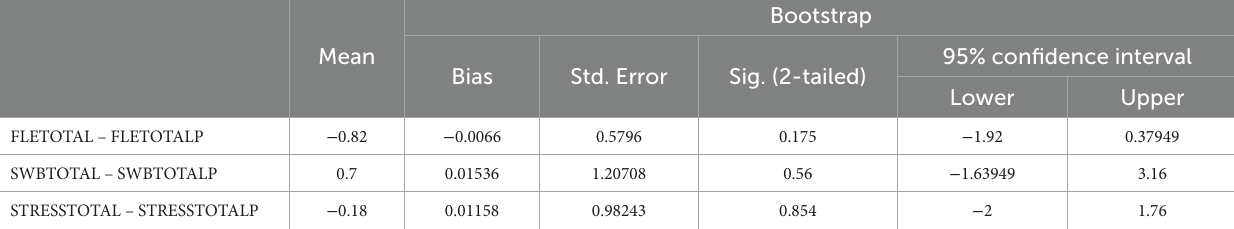
TABLE 2 Bootstrap results based on 1,000 bootstrap